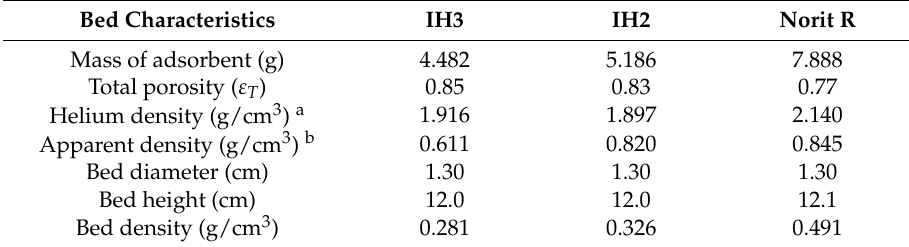
Table 4. Bed characteristics for the breakthrough experiments.